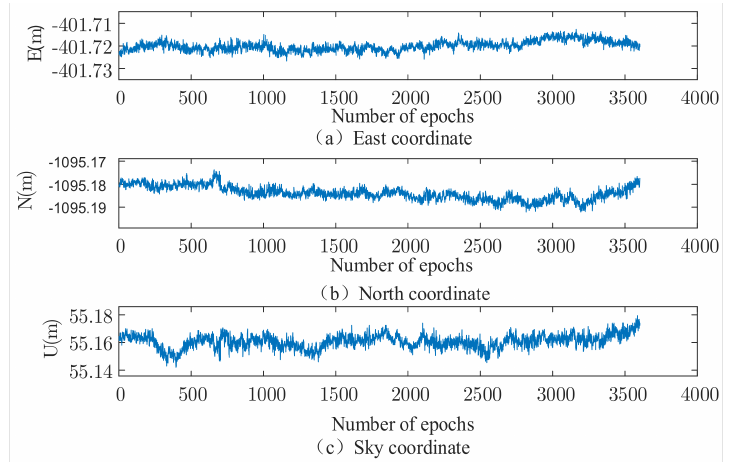
Figure 5. Measured data 2, three-dimensional baseline results of robust